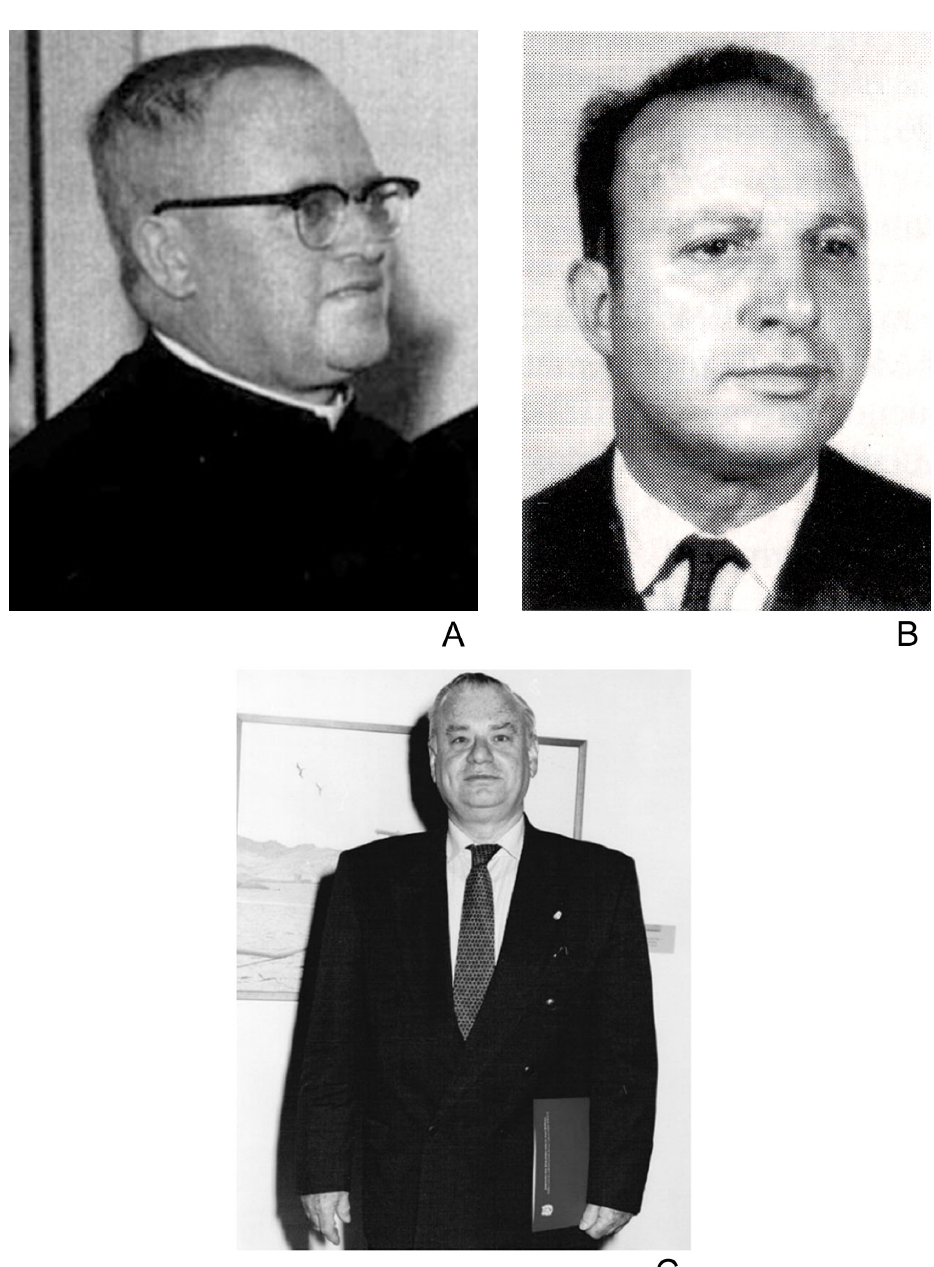
Fig. 4. The three scarab beetle specialists responsible for the intense period of taxonomic activity that ‘ Canthon sensu lato’ passed through during the 1940s–1970s. Throughout that period and through tens of papers, the former concept of the genus Canthon Hoffmannsegg, 1817 was divided into several genera and subgenera, including Sylvicanthon Halffter & Martínez, 1977, published in the last work of that series. A . The Brazilian cleric, Padre Francisco Silvério Pereira, CMF (1913–1991) (image courtesy of Everardo Grossi and Brett Ratcliffe). B . The Argentinian entomologist Antonio Martínez (1922– 1993) (modified from Fritz 1994). C . The Mexican entomologist Gonzalo Halffter (b. 1932) (modified from Morrone